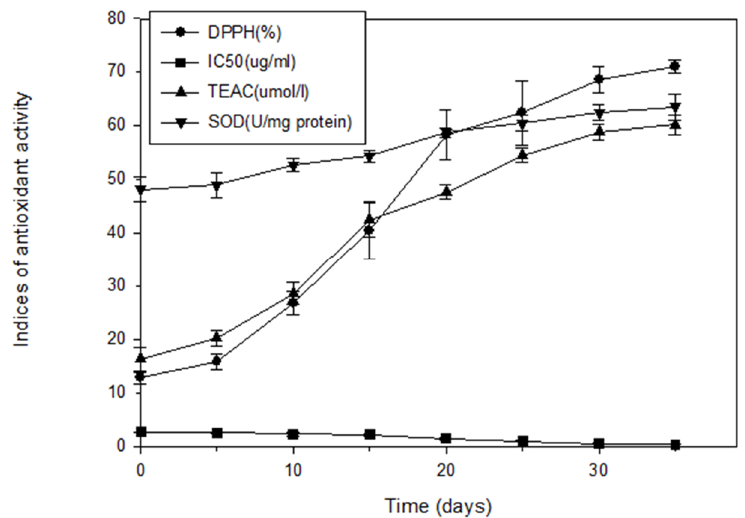
Figure 1. Antioxidant capacity of fresh and aged garlic extracts during the aging process. Each experiment was performed in triplicate, and the results (DPPH scavenging capability (%), IC 50 (μg/mL), Trolox equivalent antioxidant activity (TEAC, mmol/L), and SOD (U/mg protein)) are expressed as the average of three measurements ± standard deviation.